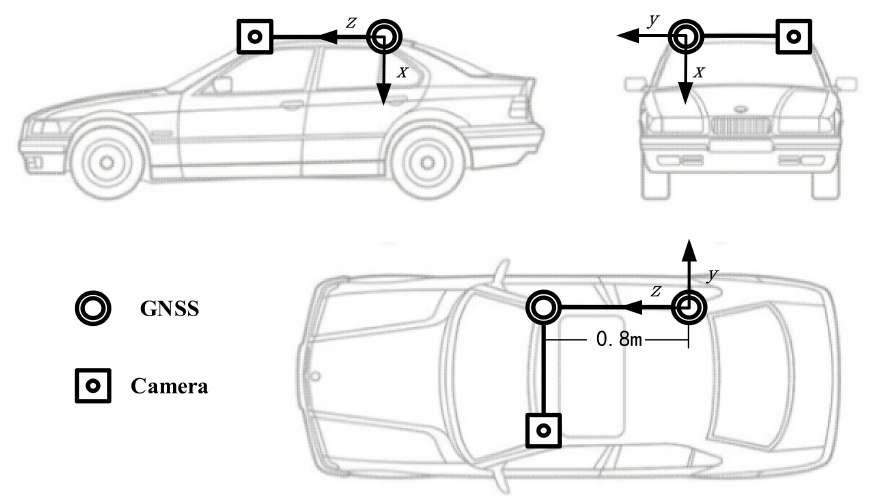
Figure 7. (Top left–bottom right) Experimental equipment, sensor layout, campus scene, Longchi tunnel